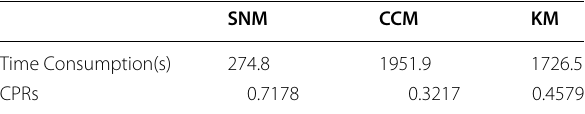
Table 5 Time consumption and CPRs of different methods for tooth broken fault signal